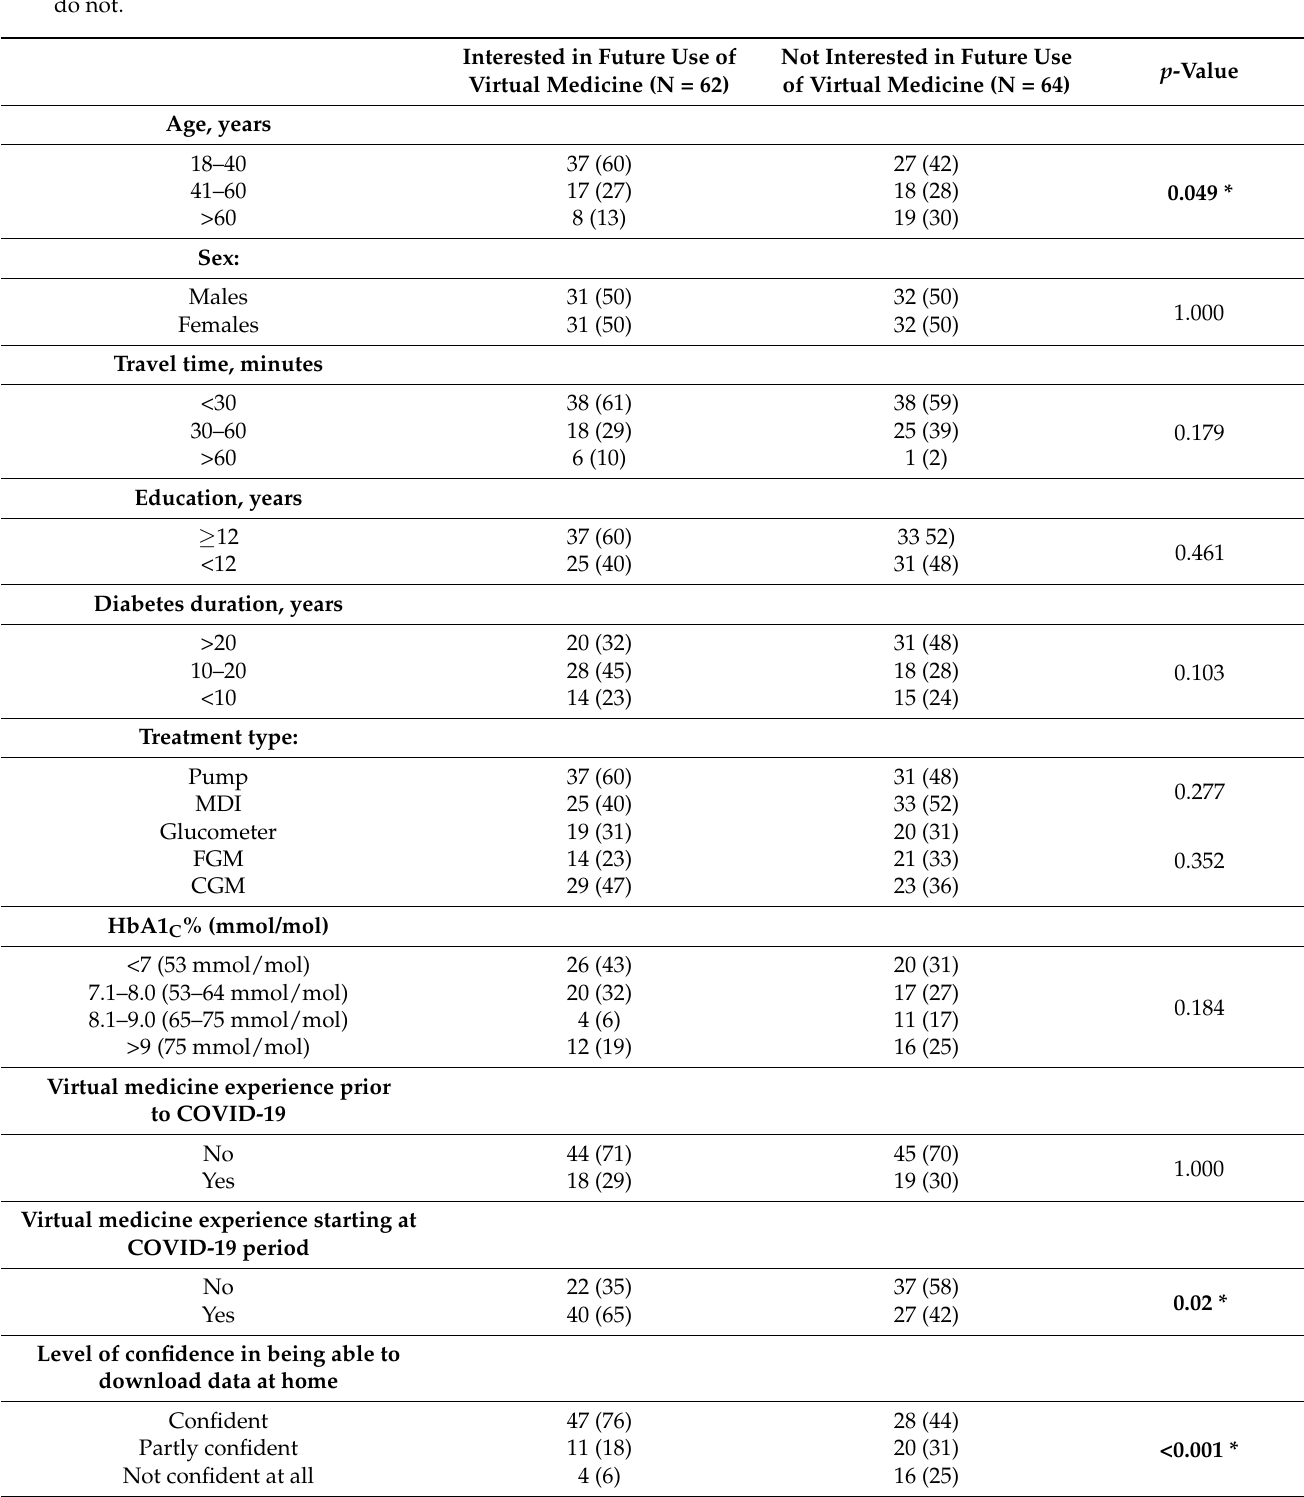
Table 3. Comparison of baseline characteristics between patients who wish to use telemedicine in the future and those who do